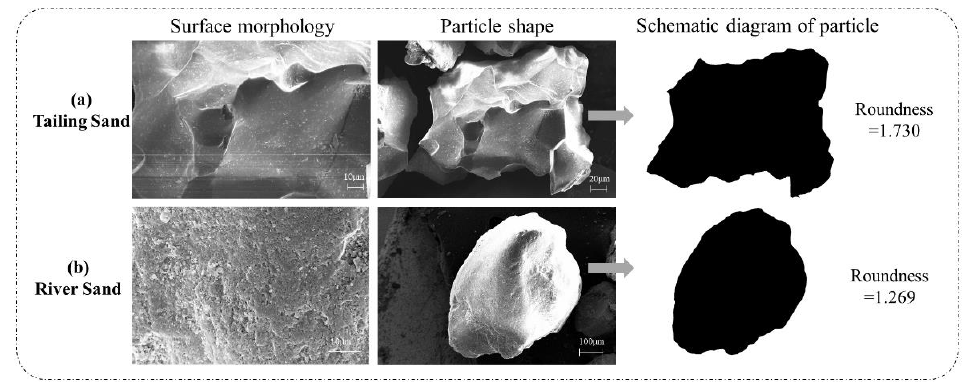
Figure 4. SEM images of iron tailings ( a ) and natural river sand ( b ).